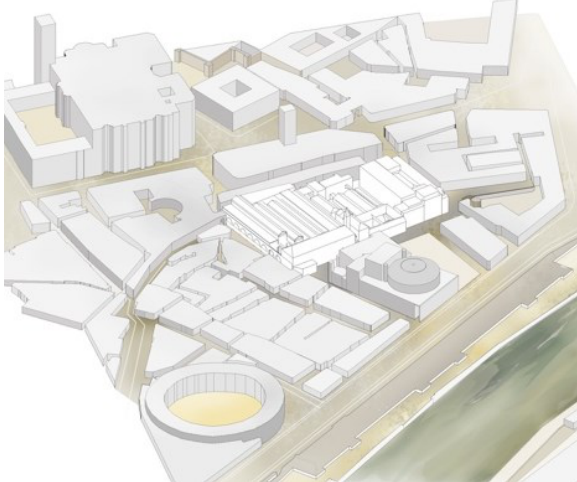
Figure 6. Volumetry of the shipyards’ pre-existence in their current status (The authors,